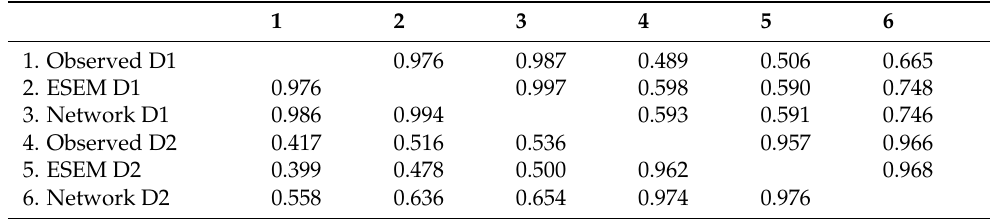
Table 3. Correlations among the observed scores, factor scores from the exploratory structural equation modeling (ESEM), and network scores in Cohort 1 ( n = 2226, lower triangle) and Co- hort 2 ( n = 655, upper triangle) for Dimension 1 (D1, “Working conditions”) and Dimension 2 (D2, “Cognitive demands”) of the Work Annoyance